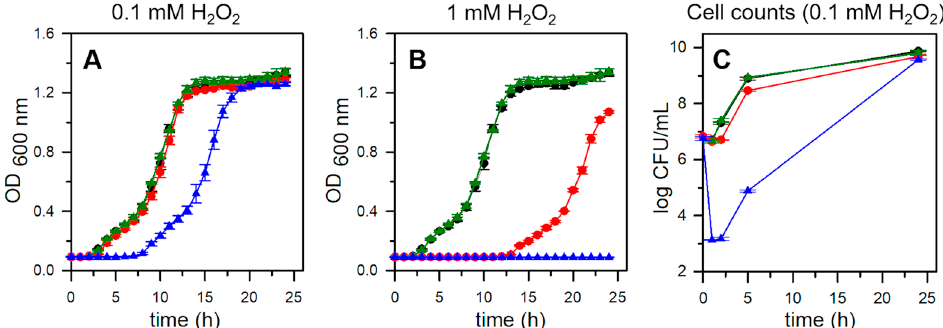
Figure 8. Pa Dps protects P. aeruginosa from H 2 O 2 -mediated oxidative stress. PAO1 (black), PAO1 + H 2 O 2 (red), Δ dps (green), Δ dp s + H 2 O 2 (blue). Late stationary cells grown in PI media supplemented with 1 μ M Fe were diluted in PI supplemented with 4 μ M Fe, exposed to ( A ) 0.1 mM or ( B ) 1 mM H 2 O 2 , and cultured while monitoring the OD 600 . The extended lag phase in A and no growth in B observed with the Δ dps cell cultures indicate the increased sensitivity of the mutant to H 2 O 2 . Each growth curve was constructed from the average of 3 replicate wells. ( C ) Monitoring cell growth by enumerating viable cells after treatment with 0.1 mM H 2 O 2 reveals that survival of H 2 O 2 -mediated oxidative stress is significantly aided by the presence of Pa Dps. Mean values and standard devia-